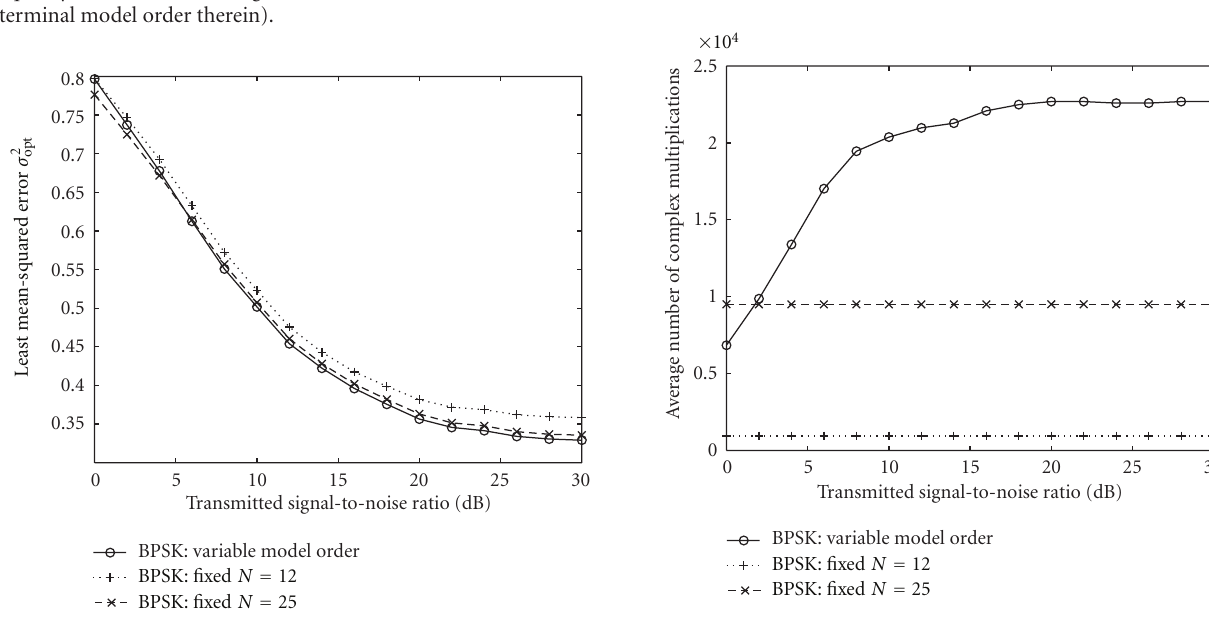
Figure 6: The corresponding computational complexities to versus signal-to- opt Figure 4 versus signal-to-noise ratio (the threshold for our variable model scheme is τ J = 1 /